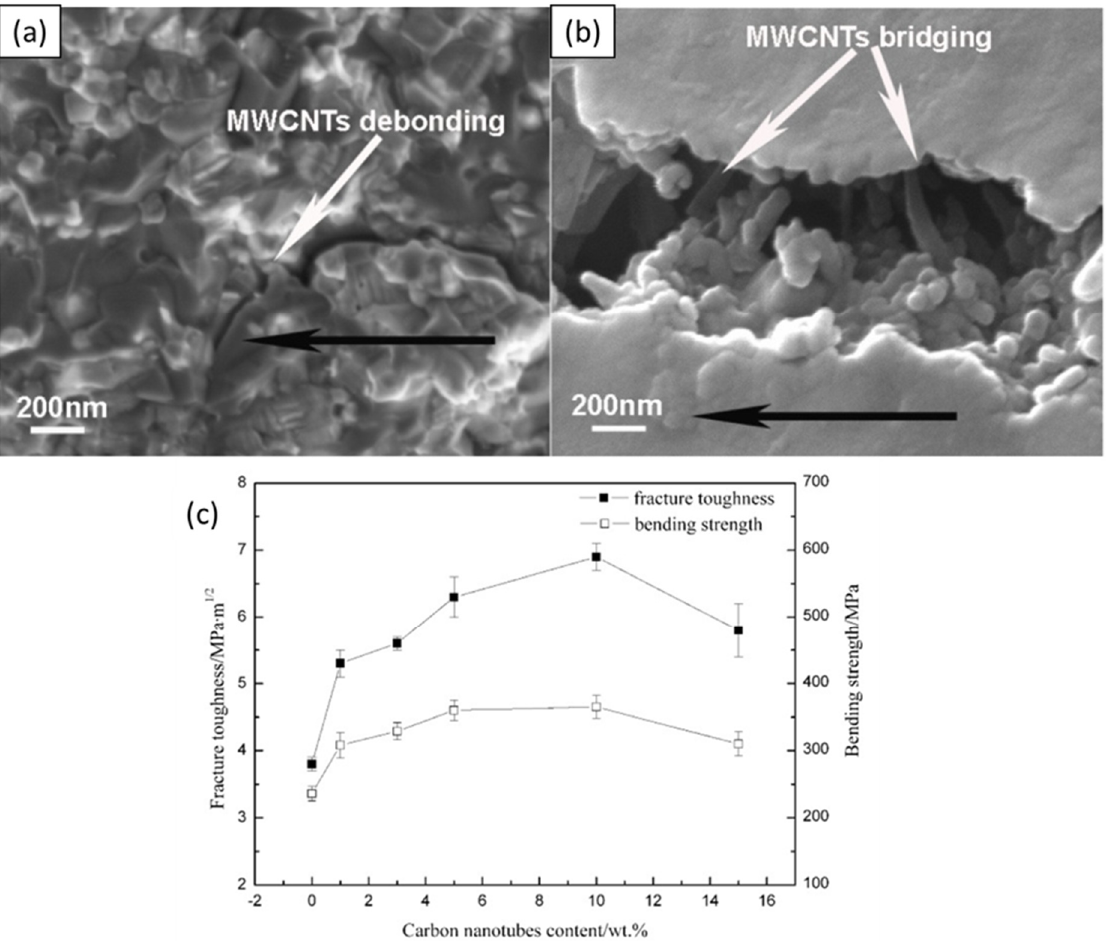
Figure 18. SEM image and mechanical properties of CNTs-SiC composites. ( a ) CNTs debonding was observed in the 1 wt.% CNTS-SiC, and ( b ) CNTs bridging was observed in the 5 wt.% CNTs-SiC. CNTs bridging dissipates the energy under an external load, and it increases the K IC and the bending strength, as shown in ( c ). (Adapted with permission from ref. [166]. Copyright 2016 Elsevier.)